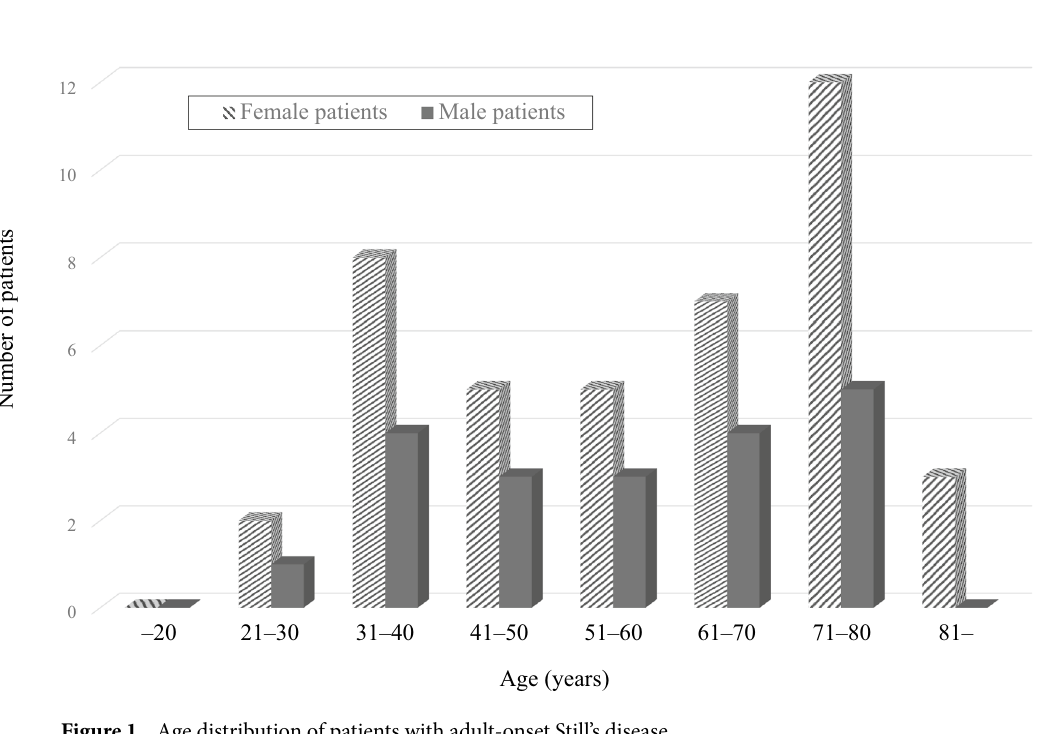
Figure 1. Age distribution of patients with adult-onset Still’s